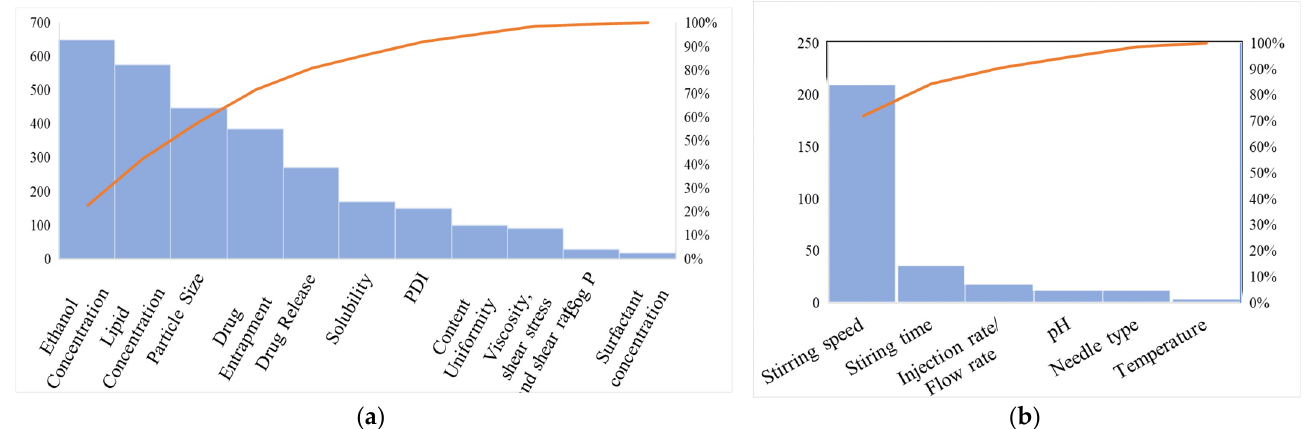
Figure 3. Pareto chart explaining quality attributes ( a ) critical material attributes ( b ) critical process parameters.